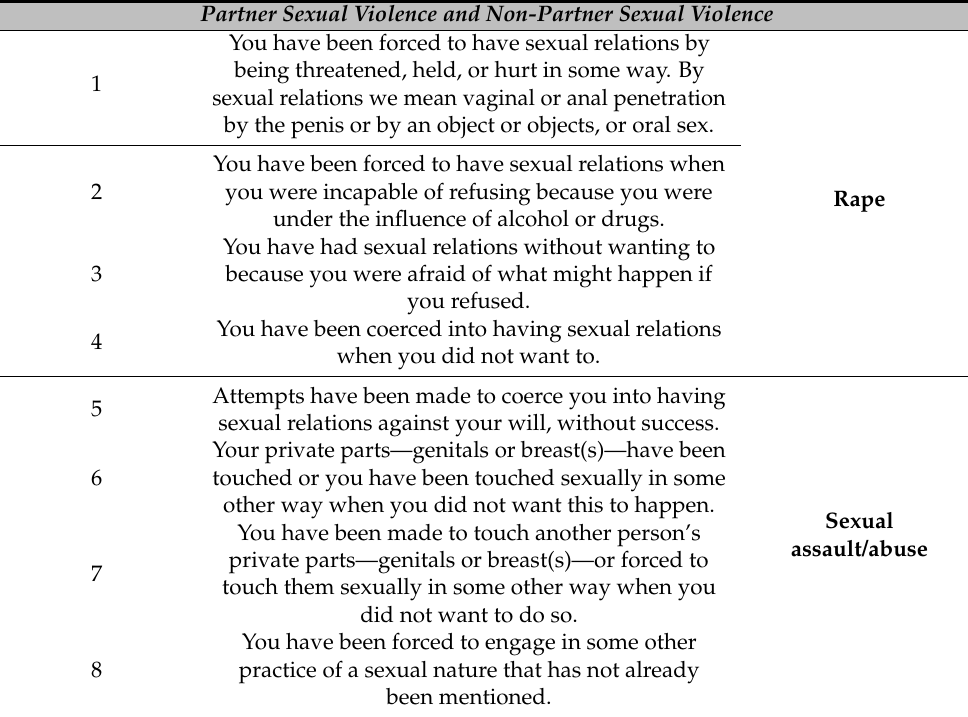
Table A1. Forms of sexual violence included in the